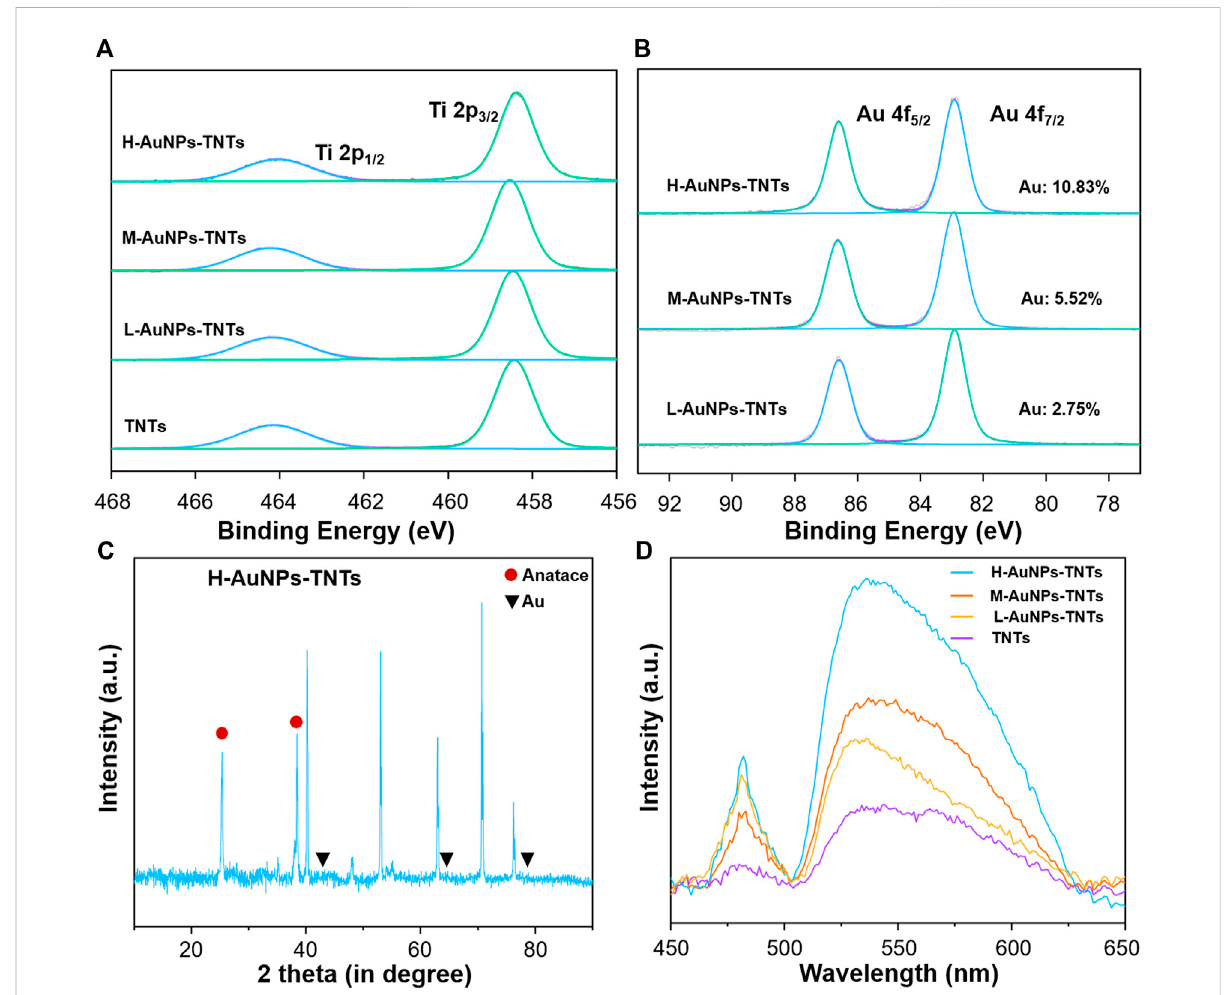
FIGURE 2 (A) XPS measurement of TNTs and AuNPs-TNTs substrate. (B) XPS measurement of Au 4f spectra for AuNPs-TNTs. (C) XRD patterns